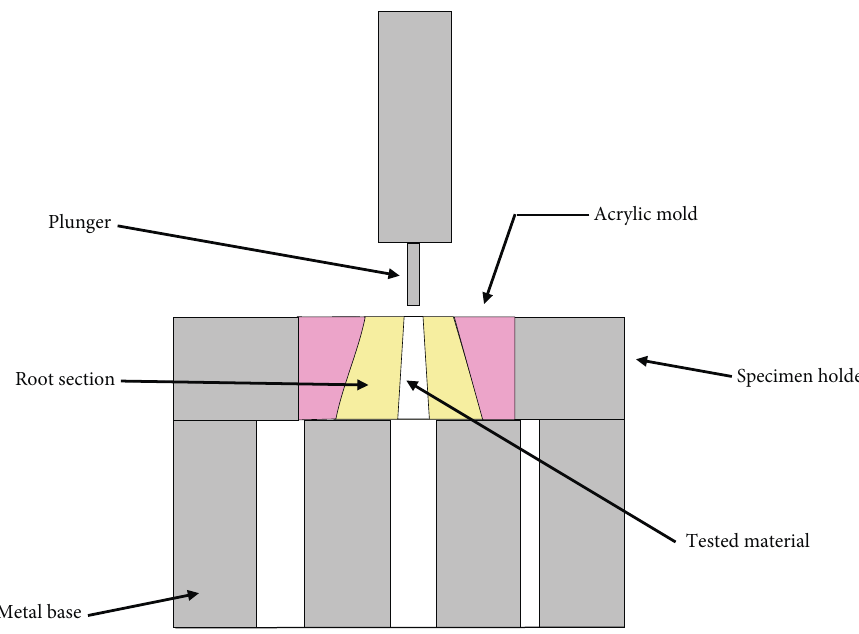
Figure 1: Illustration for the push-out test of the material tested from the root canal